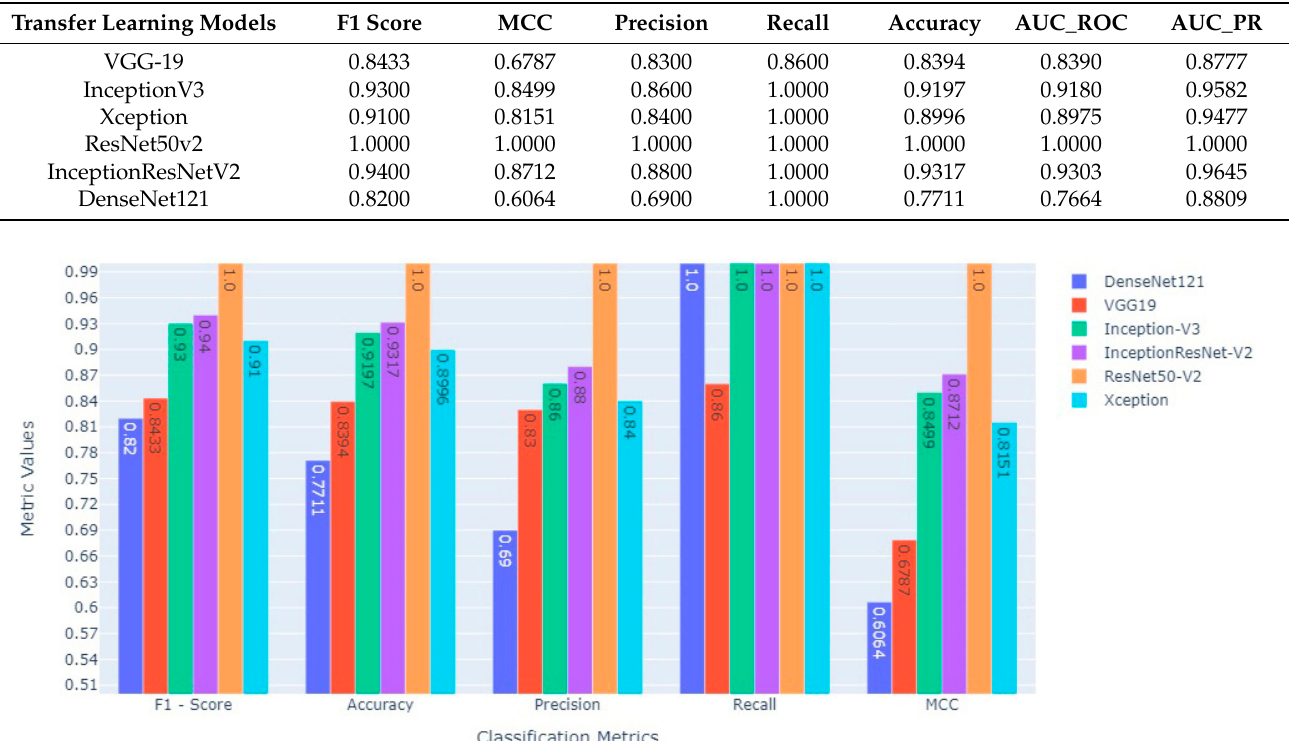
Figure 10. Comparative performance evaluation of various statistical evaluators between six state ‐ of ‐ the ‐ art deep transfer learning models to classify fibrosis and non ‐ fibrosis images using the 10% independent testing CT scan image data set .